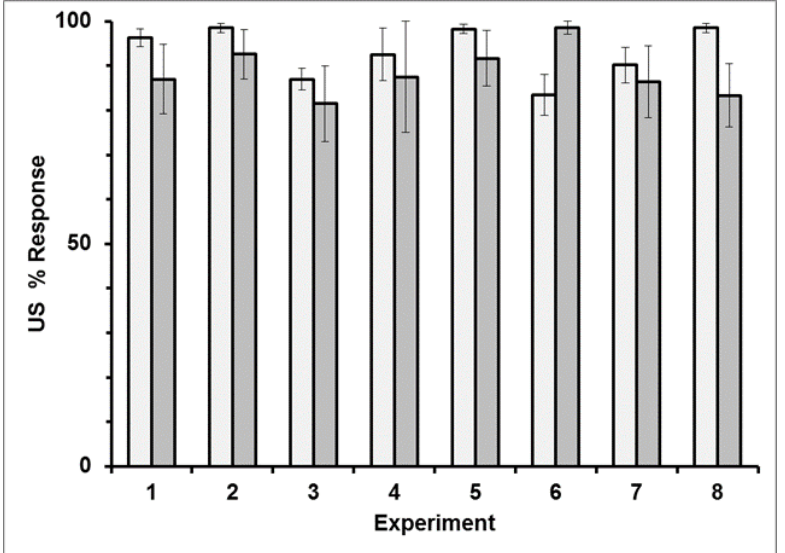
Figure 2. Average US PER response ( ± SE) in all eight experiments for day 1 (light bars) and day 2 (dark bars) using caged stingless bees, Melipona eburnea.